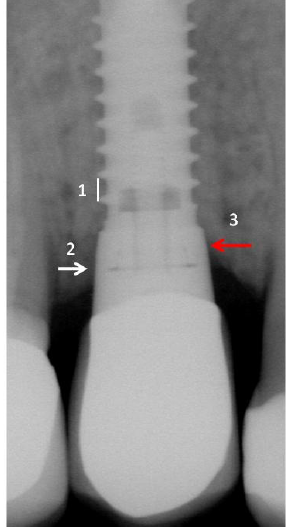
Figure 1. Quantitative X-ray Evaluation: 1 : The height of implant thread (vertical white bar = 1.00 mm); 2 : Upper implant shoulder (horizontal white arrow); 3 : The most coronal bone-to-implant contact point (horizontal red arrow).